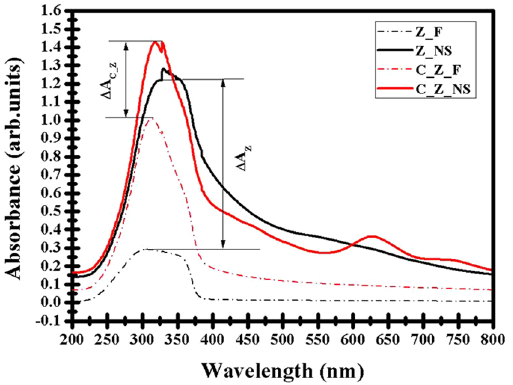
Figure 6. Room temperature UV-Vis absorption spectra of Z_F, Z_NS C_Z_F and C_Z_NS samples, under normal incidence, with a clear indication of an increase in the absorption ( Δ A) as a result of the nanoshell structure.